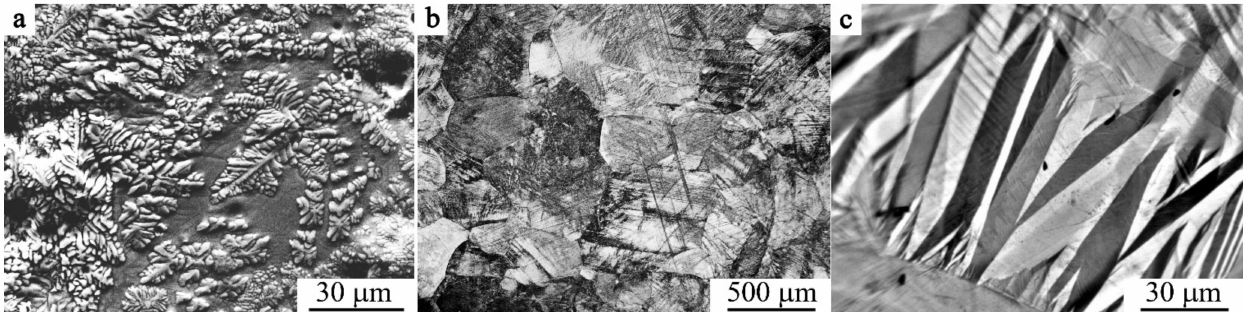
Figure 1. ( a ) SEM image and ( b , c ) OM images of the alloys ( a , c ) Cu–13.5Al–3.5Ni and ( b ) Cu–14Al-3Ni in the ( a ) as-cast, ( b ) austenite, and ( c ) martensite